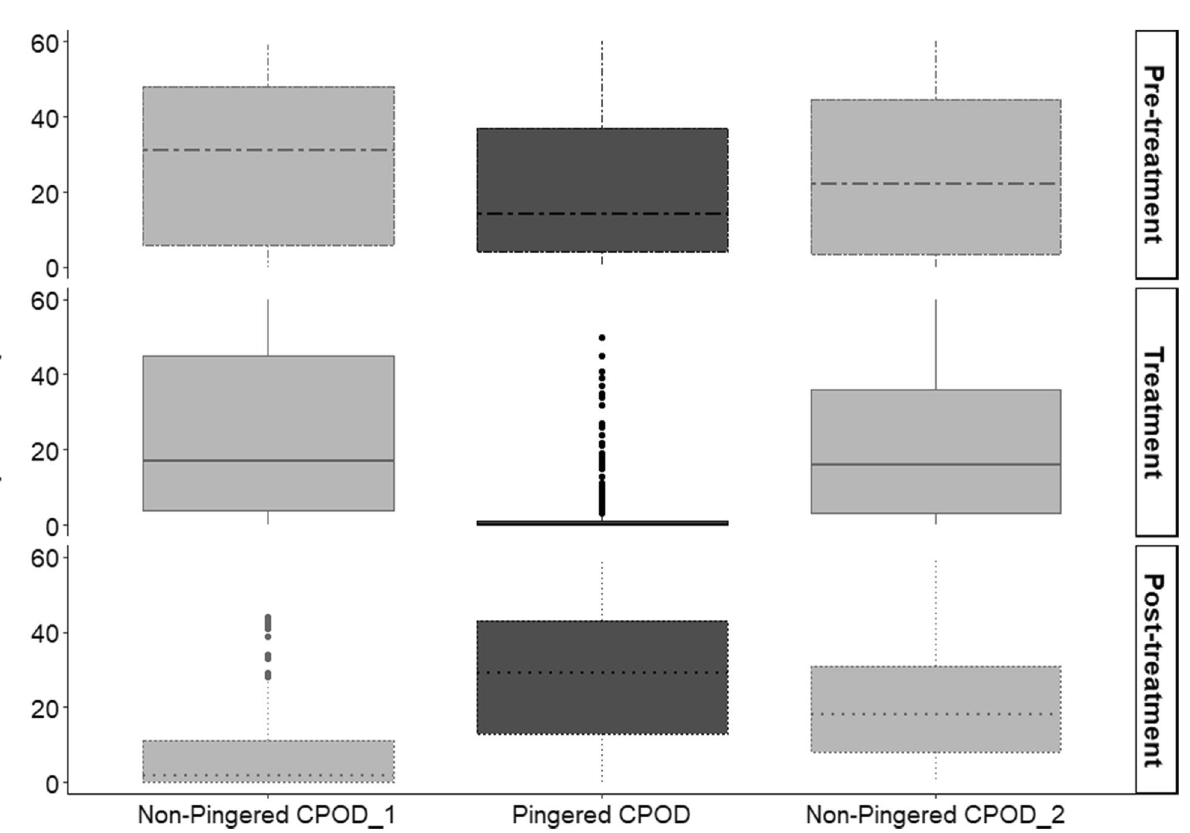
Figure 5. Dolphin presence recorded in the three CPOD sites during the pre-treatment, treatment and post- treatment